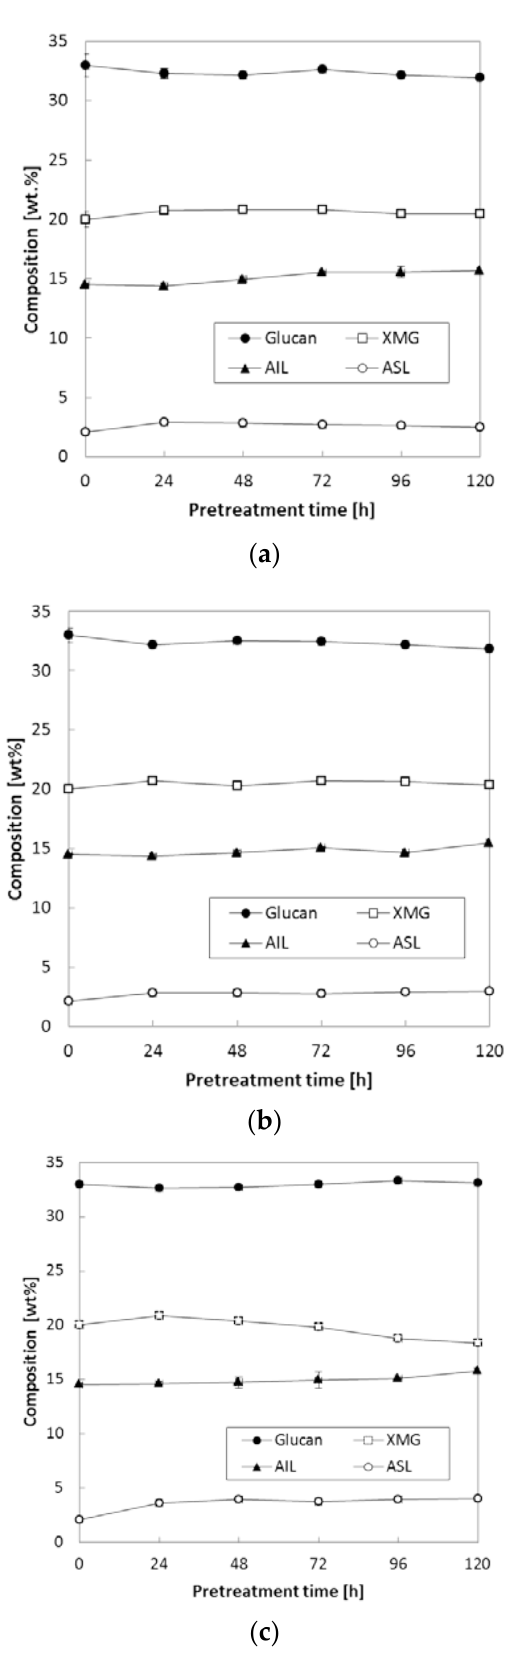
Figure 2. Effects of pretreatment temperature and time on the composition of pretreated corn stover. Pretreatment: 0.16 (g NH 3 )/(g biomass), S/L ratio = 0.47, 24–120 h. ( a ) 90 °C, ( b ) 120 °C, ( c ) 150 °C. The data in the figure show mean values.